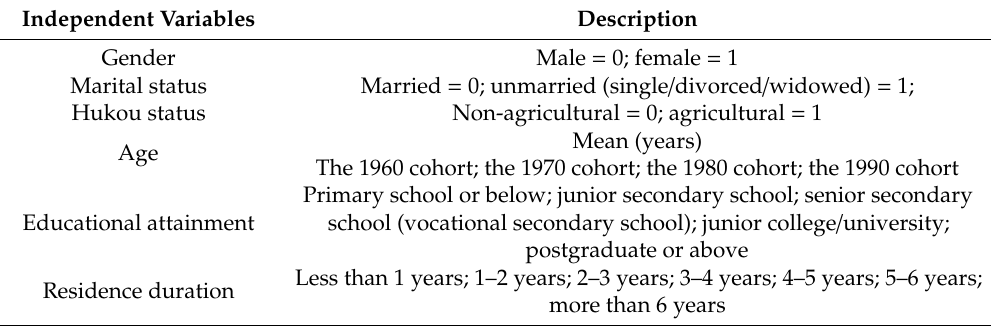
Table 2. Descriptions of the independent